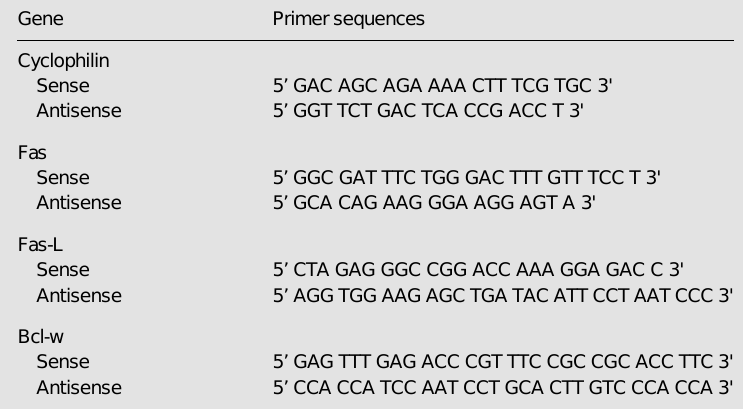
Table 1. Primers for mouse cyclophilin, Fas, Fas-ligand (Fas-L) and Bcl-w reverse transcriptase-PCR.